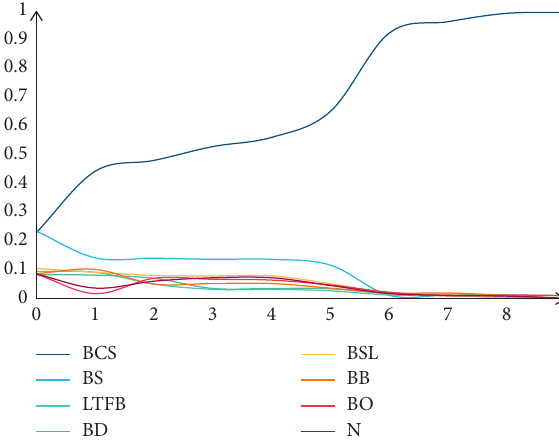
Figure 7: Trend of belt conveyor health status.